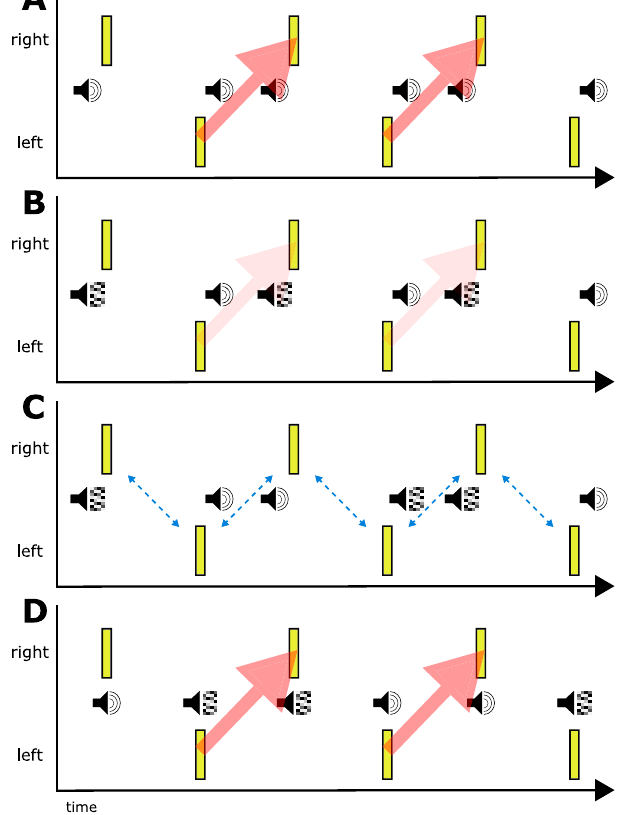
Figure 1. A depiction of the experimental conditions and results in Roseboom et al . 19 . ( A ) Identical cross- modal flankers (pure-tone here) presented asynchronously with the visual flashes resulted in a strong impression of motion (indicated by the heavy red arrows). ( B ) When successive flankers differed (audio noise and pure-tone here), the influence of the asynchronous flanker timing was reduced, resulting in a much weaker impression of motion. ( C ) When successive flankers differed by pair and the pairwise features were in conflict with the influence of timing, the perceived motion direction was ambiguous (depicted by the bi-directional blue arrows). ( D ) When successive flankers differed by pairs and there was no temporal difference between visual flashes and cross-modal flankers, this resulted in an impression of rightward motion of a similar magnitude to that apparently driven by temporal ventriloquism. Similar results were obtained when the difference between flanker signals was across-modality (tactile-audio) as when it was within-modality (pure tone-audio